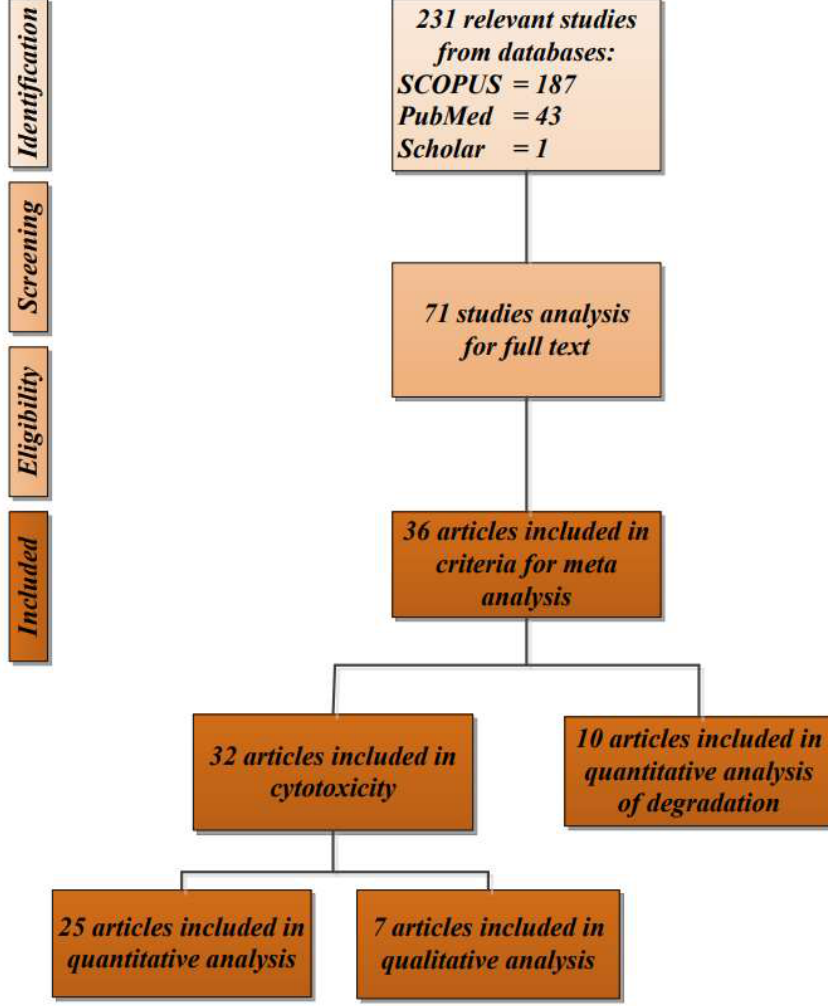
Figure 1. Flow diagram of the study selection of the articles included in the systematic review.